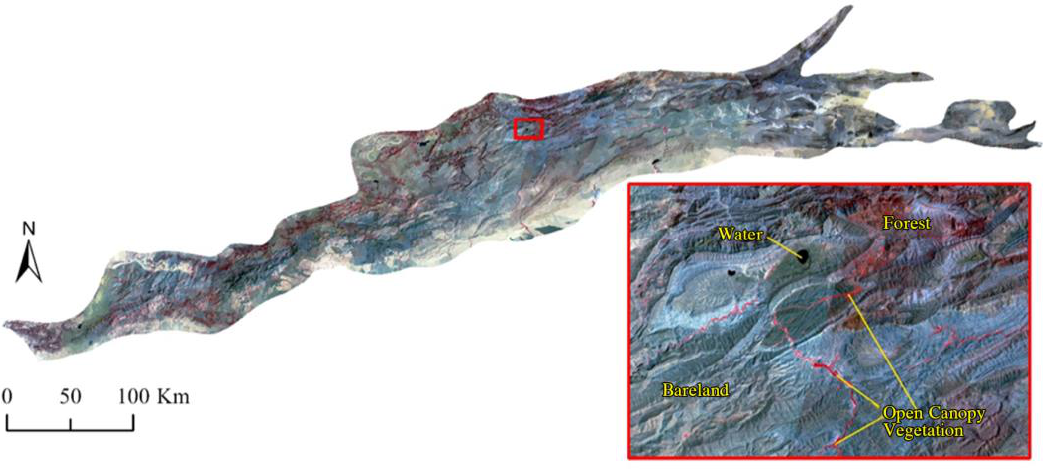
Figure 3. False color mosaic of the High Atlas Mountains in 1990 based on Landsat images. Table 2. Type of classes used for the classifications, and detailed descriptions of what each class covers, with the samples collected for the SVM classification of vegetation in the High Atlas Mountains of